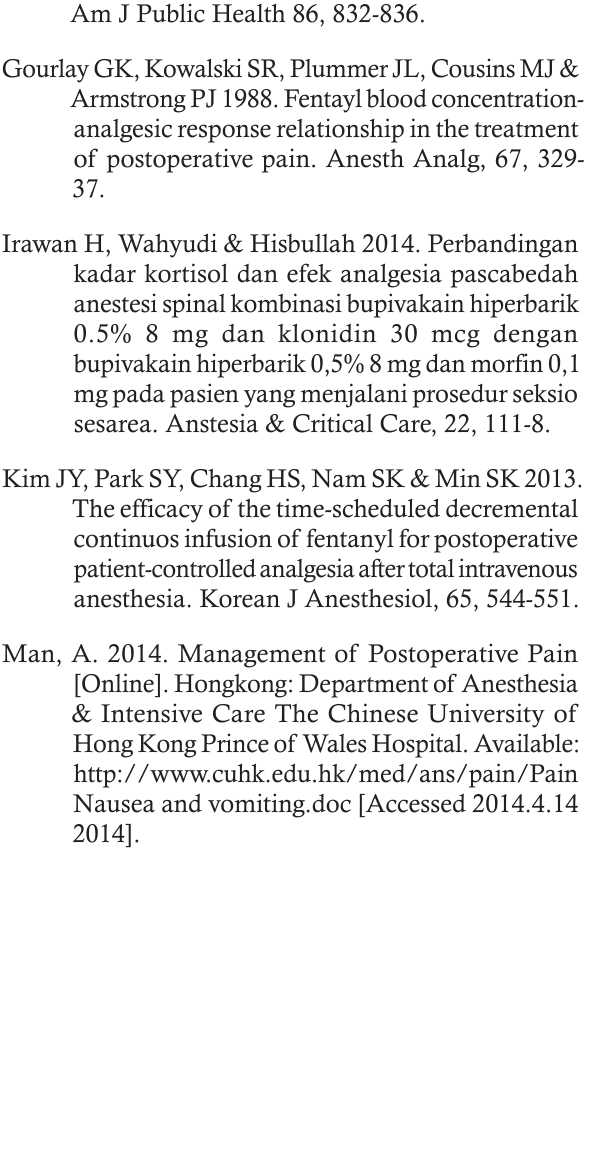
Comparison in Efficacy between Fentanyl Continuous Infusion and Intrathecal